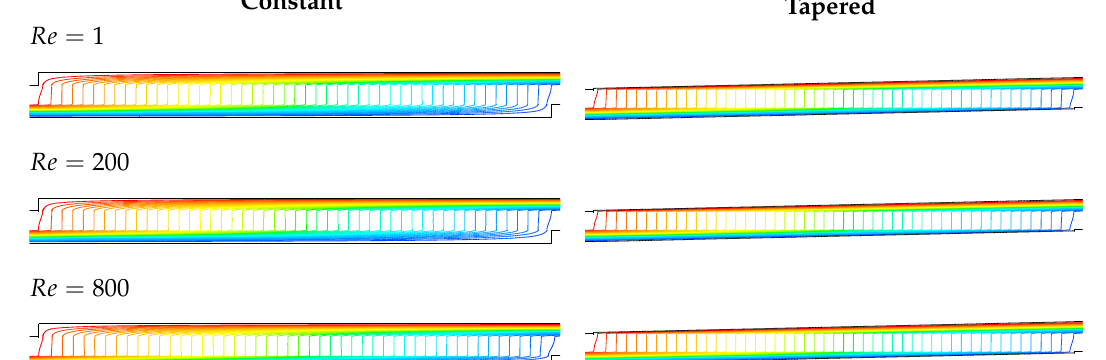
Figure A3. Streamlines in ( left ) the constant cross-section and ( right ) the tapered flow fields at different Reynolds numbers, Re , corresponding to an electrode permeability, K e = 10 − 12 m 2 ( γ ∼ 10 − 2 ) , and Λ =